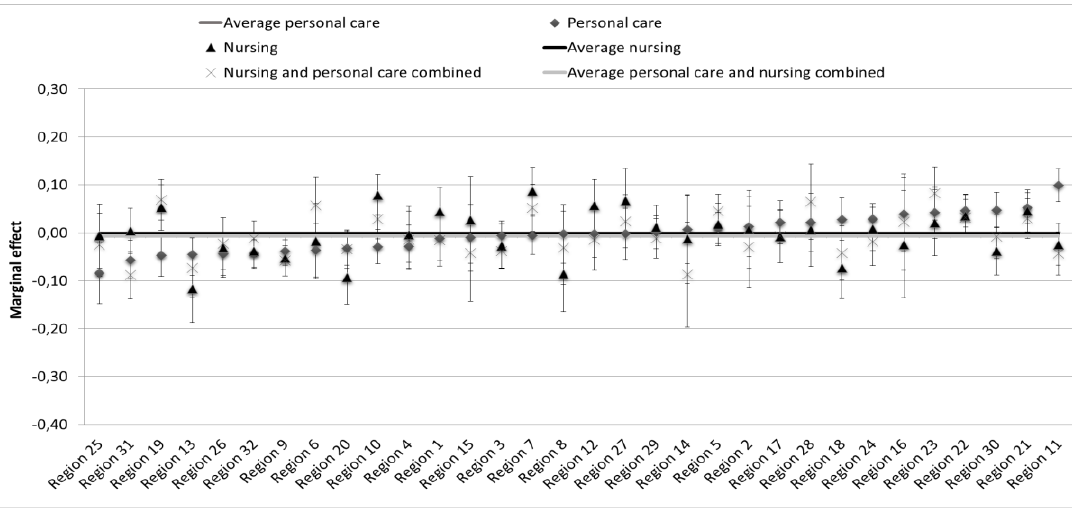
Figure A5: Variation in home care entitlements granted not processed by CNAC